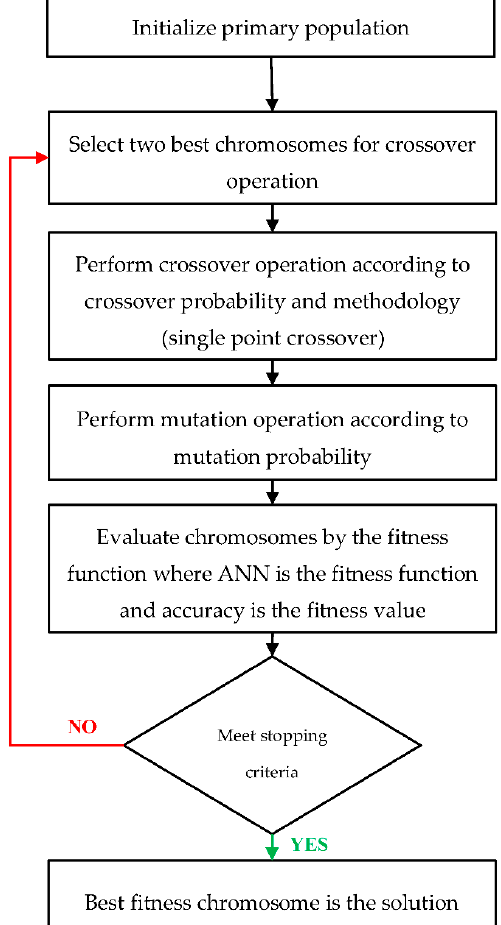
Figure 1. Flowchart of Genetic Algorithm (GA).